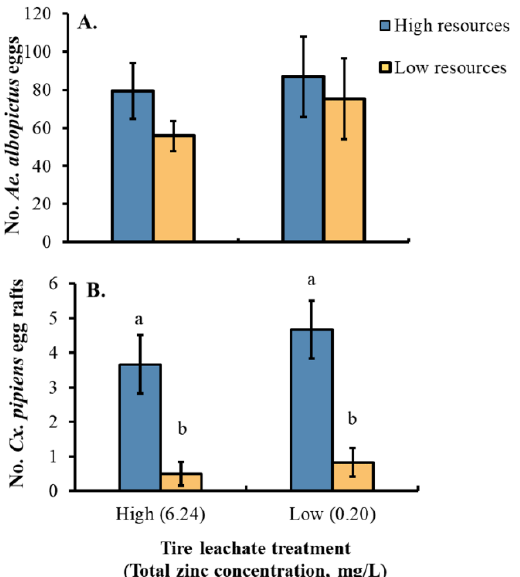
Figure 5. Least squares means (± SE) for ( A ) numbers of oviposited Ae. albopictus eggs and ( B ) numbers of Cx. pipiens egg rafts by tire leachate concentration (high, low) and food resources (high, low). Data were statistically tested using ANOVA. Significant pairwise comparisons among treatment levels are indicated by different letters above bars ( p < 0.05). No letters indicate no significant pairwise differences.